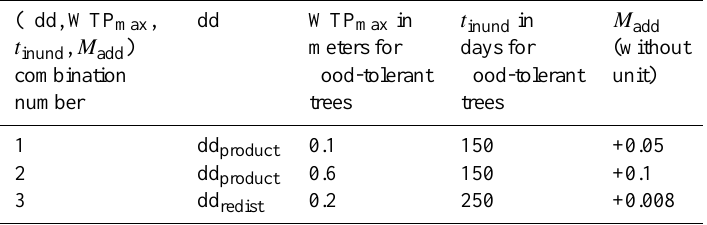
Table 1. Different combinations of (fldd, WTP max , t inund and M add ). Only the values of (WTP max , t inund , M add ) for flood-tolerant trees vary from one simulation to the other. For all simulations, (WTP max , t inund ) for flood-tolerant grasses are set to (10m, 10days). M add has a meaning only for tree PFTs (no population density for grass